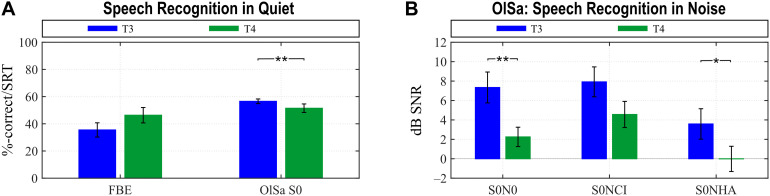
Improvement of hearing with the CI ear between T3 and T4. Significant improvements are seen for various test constellations in quiet (A) and background noise (B). In the FBE higher values (%-correct) indicate better performance, whereas in all OlSa tests, lower values indicate better performance. Group means with their standard errors are shown (**p < 0.002, *p < 0.01).